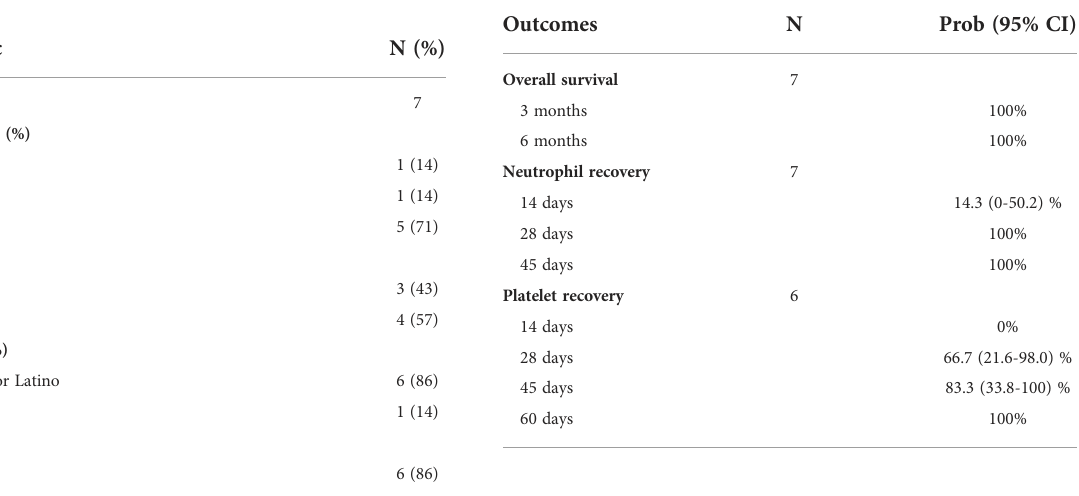
TABLE 6 Outcomes of patients who received stem cell products from COVID-19 positive donors.